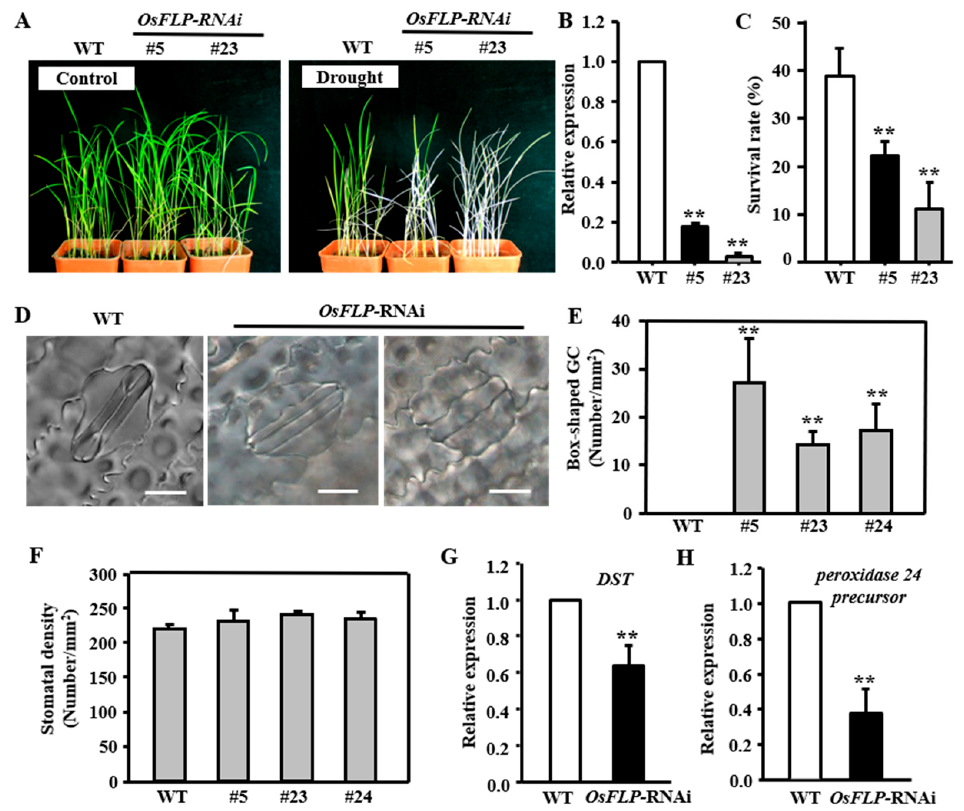
Figure 4. Knockdown of OsFLP results in drought sensitivity and abnormal stomata. ( A ) Four-week rice seedlings were grown under normal conditions and were not watered for 10 days and re-watered for 5 days. ( B ) The expression levels of transgenic lines were detected by qRT-PCR. Error bar means ± SD. ( C ) Analysis of survival rate after drought treatment. Error bar means ± SE ( n > 36 plants). ( D ) Abnormal box-shaped guard cells were observed in OsFLP -RNAi lines. Bars = 10 µm. ( E ) The number of box-shaped guard cells was increased in three OsFLP -RNAi lines. Error bar means ± SD. ( F ) No significant difference in stomatal density was found between OsFLP -RNAi and WT mature leaves ( n = 10 plants). ( G , H ) The transcript level of stomatal closure-related genes DST and peroxidase 24 precursor were significantly suppressed in OsFLP -RNAi lines. Error bar means ± SD. Asterisks indicate a significant difference to wild-type (Student’s t -test, ** p < 0.01).